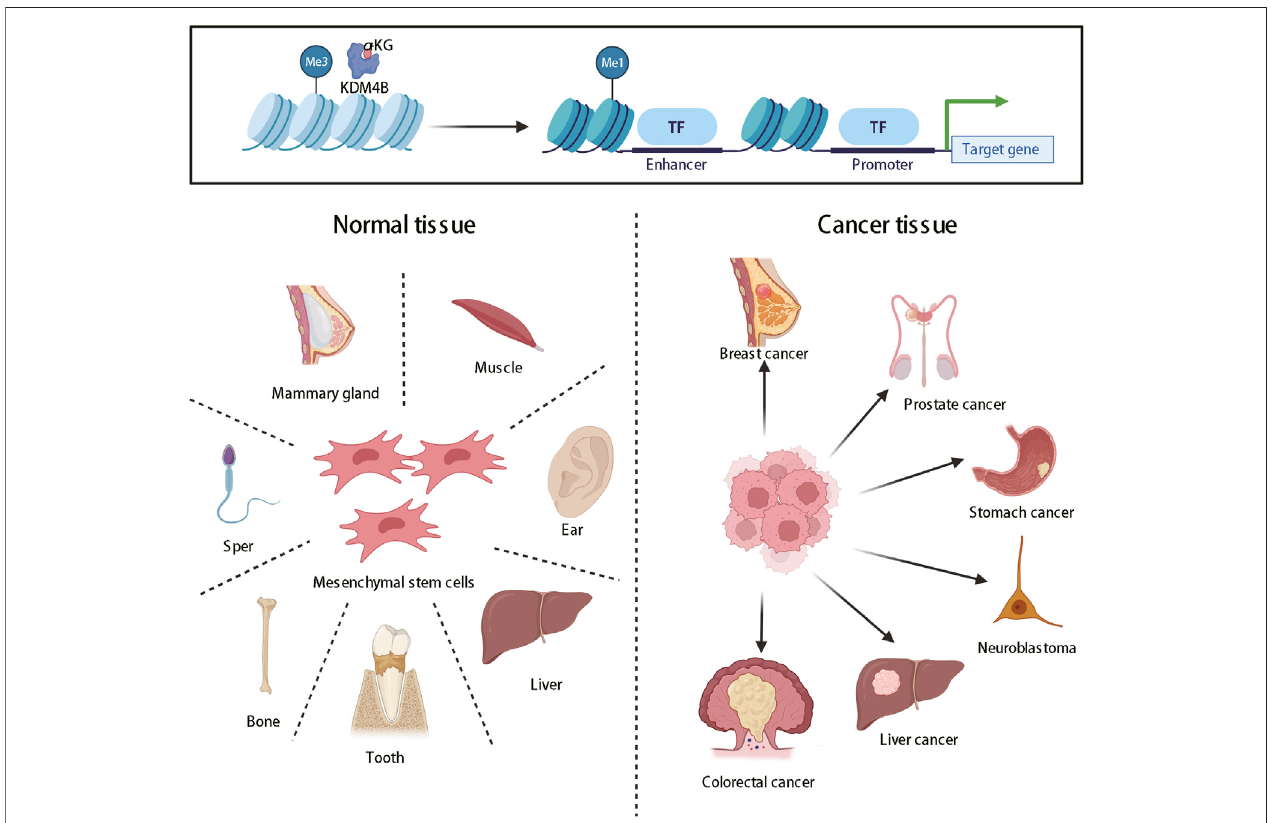
FIGURE 1 | The roles of KDM4B in organ differentiation and tumor formation. KDM4B switches on gene expression through histone demethylation and produces pleiotropy, which can promote not only the normal differentiation of most organs but also tumor formation.